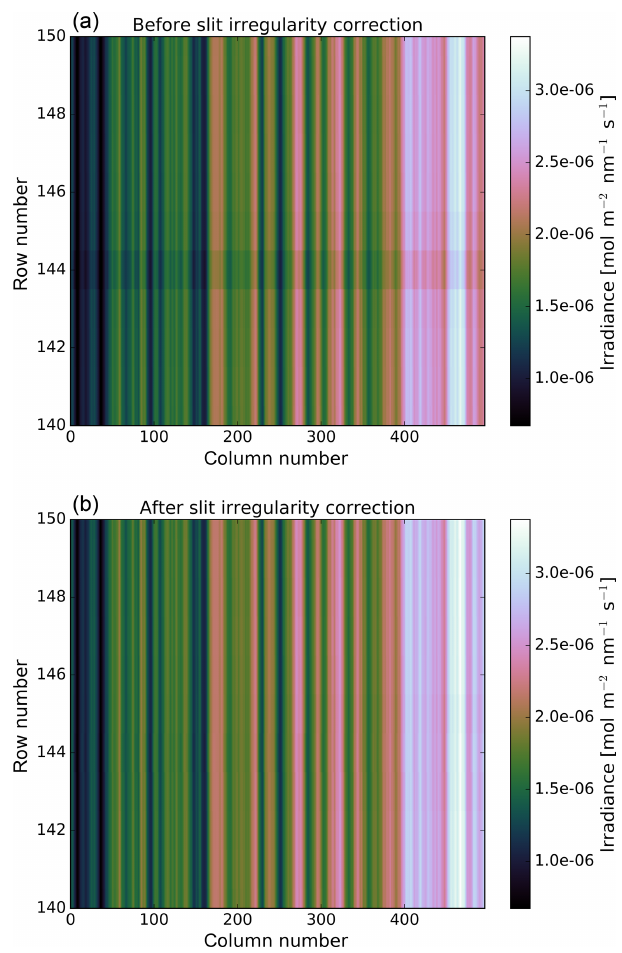
Figure 7. Focus on the rows around the slit irregularity for binned irradiance data via diffuser QVD1 for band 2 before (a) and after (b) L1b correction. Note that the binned row count is shown in the plots; the affected detector rows are rows 335–337. The correction is ef-